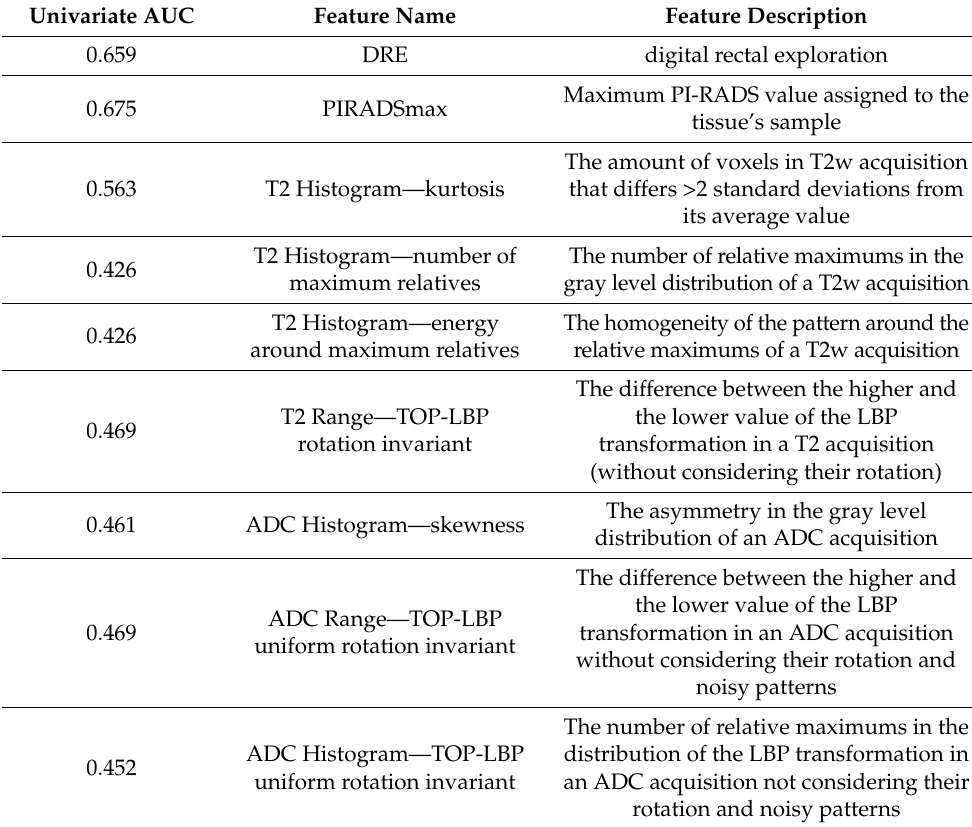
Table 2. Features description and univariate Area Under the Curve